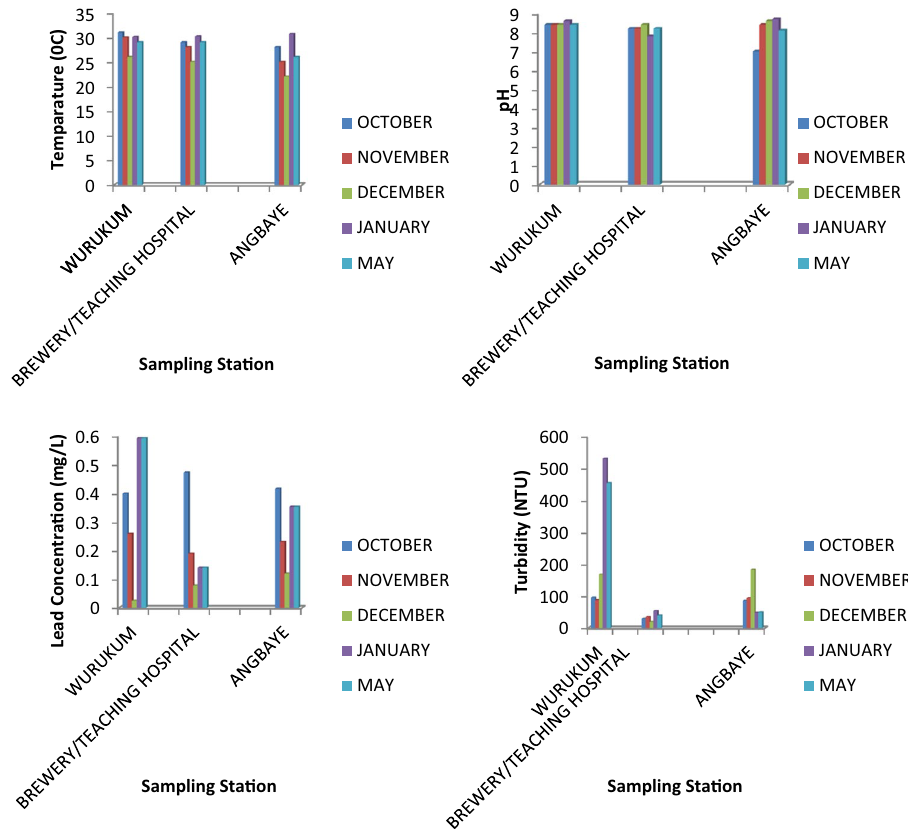
Fig. 3 Spatio-temporal variation in temperature, pH, lead and